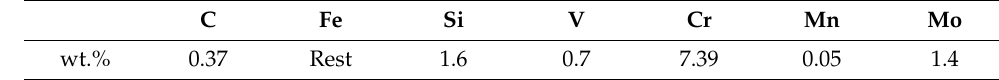
Table 1. Composition of 1.2343/H11 tool steel powder.